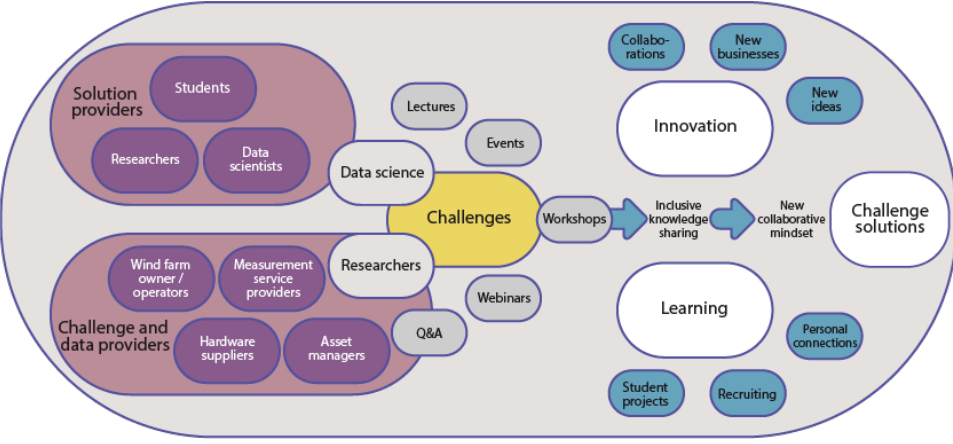
Figure 1. The value creation process of the WeDoWind